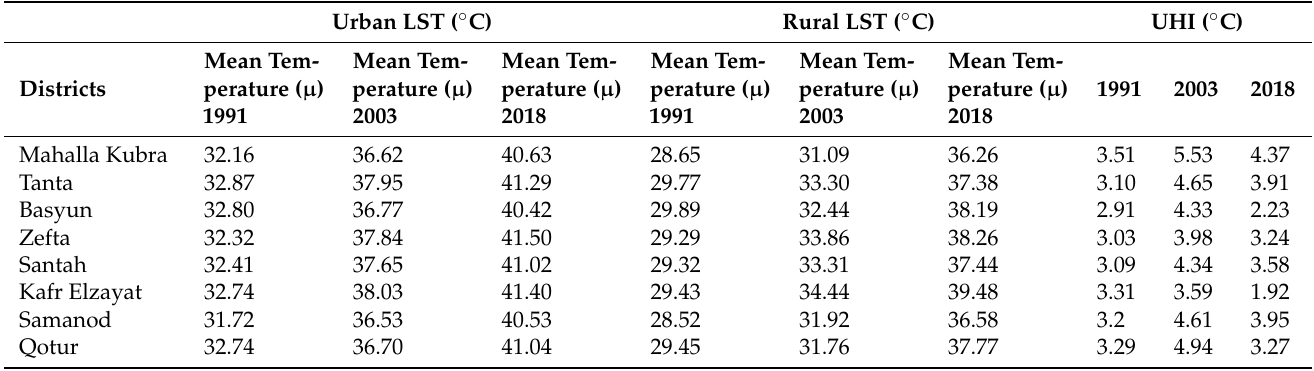
Table 8. Calculation of UHI intensities from land surface temperature (LST) based on Landsat images. Urban LST ( ◦